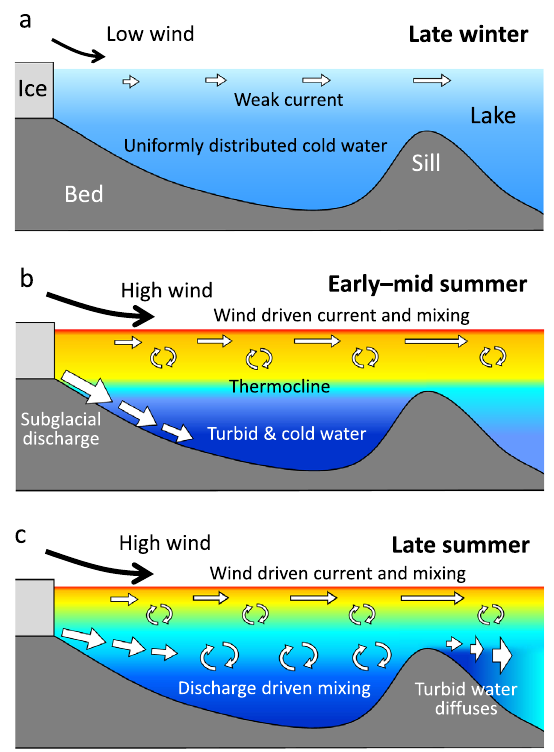
Fig. 7 Schematic diagrams showing seasonal variations in lake thermal structures and circulation. a The lake in late winter is characterized by weak current and uniformly distributed relatively cold water. b In early-mid summer, cold and dense subglacial discharge fi lls the lake deeper than the sill. Atmospheric heat is distributed to the upper layer by wind-driven circulation, resulting in the formation of a thermocline at the sill depth. c Subglacial discharge in later summer jets into the mid-layer, which drives mixing of upper warm and lowers cold